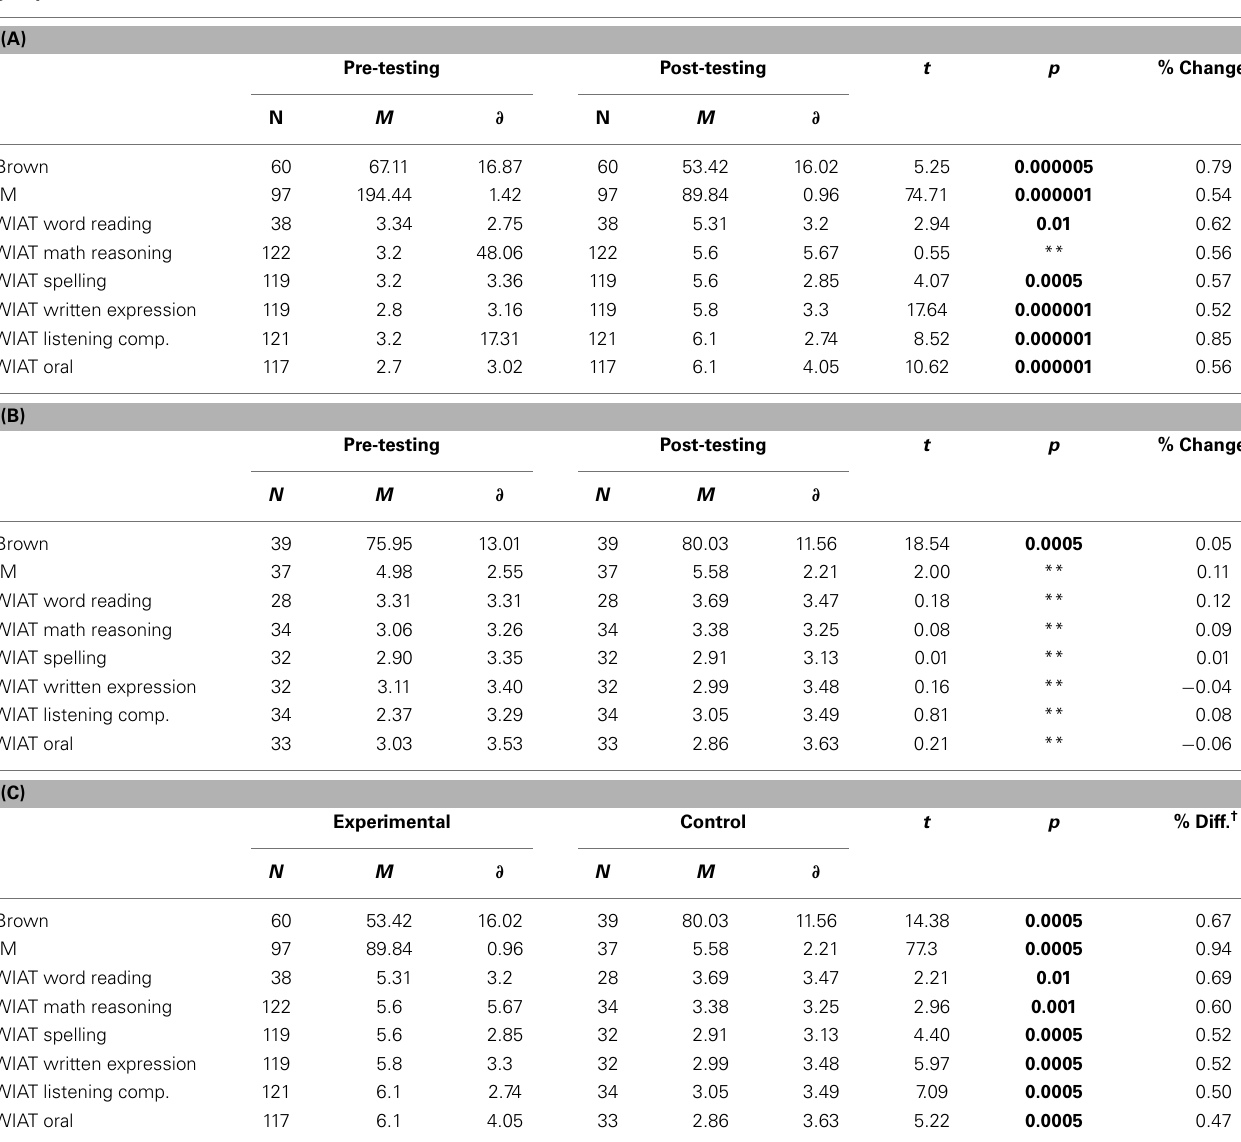
Table 1 | (A) Experimental group – pre- vs. post-testing. (B) Control group – pre- vs. post-testing. (C) Post-testing control vs. experimental